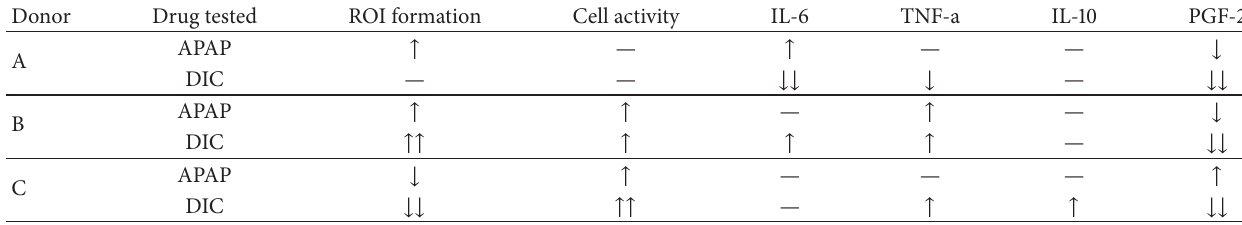
Table 2: Summary of KC activation and